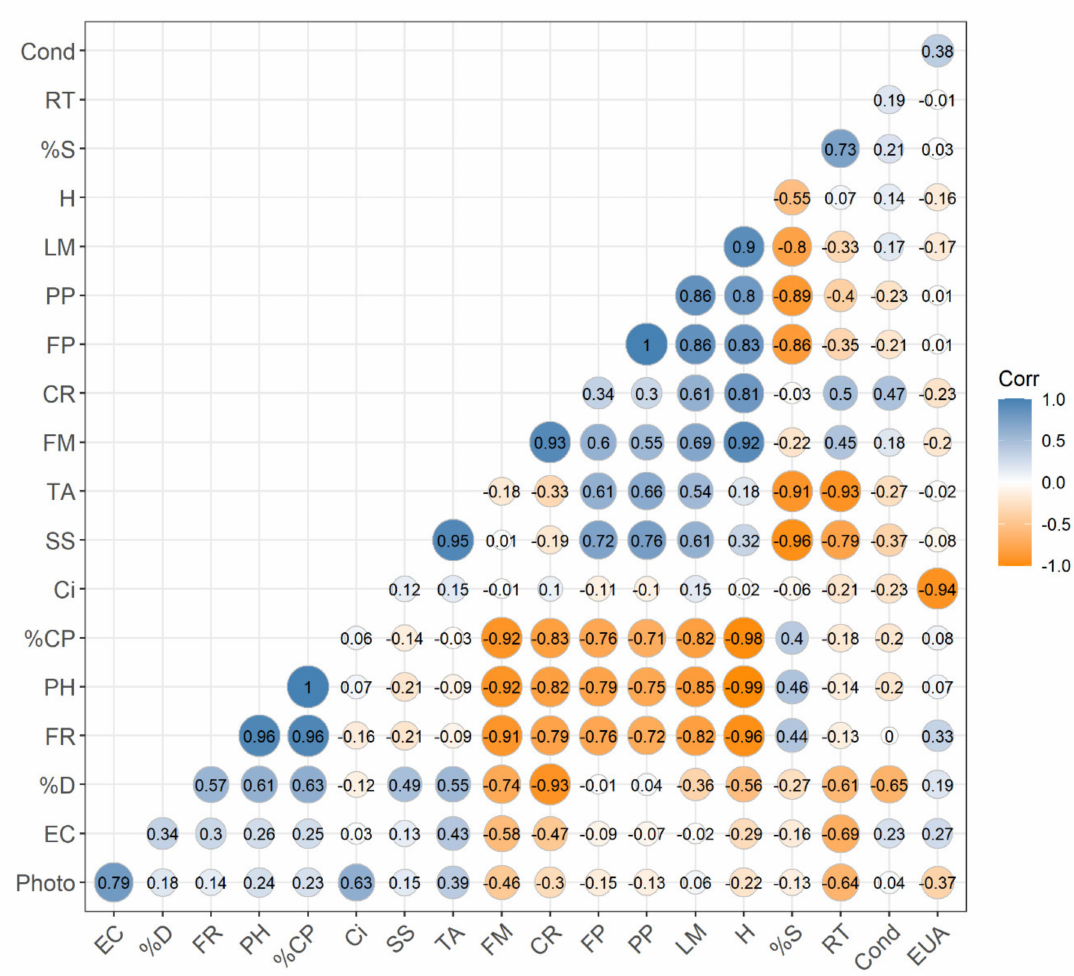
Figure 12. Correlation matrix for the six different spacing (5, 10, 15, 20, 25, and 30 cm) in the production and quality of strawberry fruits cv. ‘Pircinque’. Positive correlations are displayed in blue and negative correlations in orange color. Color intensity and the size of the circle are proportional to the correlation coefficients. Caption: FP = fruits per plant. PP = production per plant. PH = productivity per hectare. FM = fresh mass. %CP = commercial percentage. %S= small fruits percentage. %D=discard percentage. LM = epidermis luminosity. CR = epidermis Chroma. H = epidermis hue angle. FR = firmness. SS = total soluble solids. TA = titratable acidity. RT = soluble solids/titratable acidity ratio. Cond =